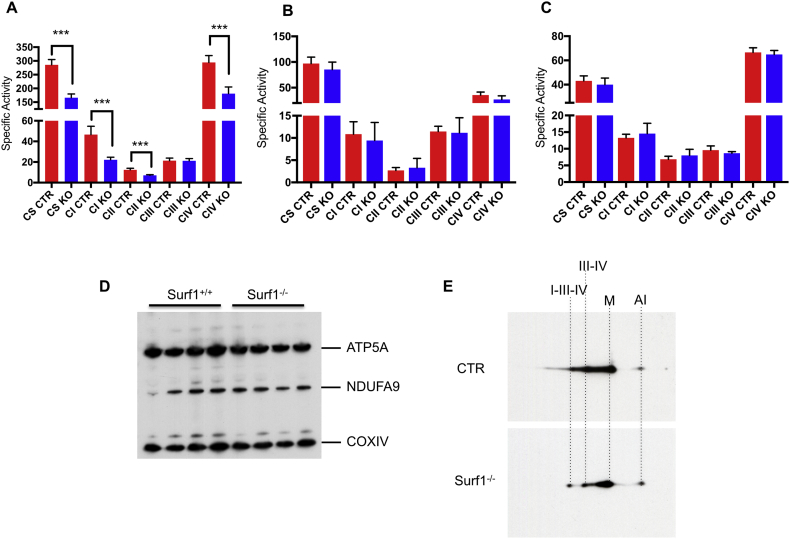
Biochemical characterization of swine SURF1−/− tissues.A–C) MRC specific activities (nmoles/min/mg of proteins) in quadriceps (A) liver (B), and brain (C) of newborn SURF1−/− piglets. Two-tailed, unpaired, unequal variance Student's t-test was used for statistical analysis (***p < 0.005).D) Western blot analysis of subunits of the respiratory chain.E) 2-D BNGE Western-blot of muscle mitochondria from a newborn SURF1−/− piglet and an age-matched control. Immunovisualization was obtained by using an anti-COI specific antibody. I-III-IV and III-IV are COX-containing supercomplexes. M indicates the COX monomer and AI a commonly detected assembly intermediate.